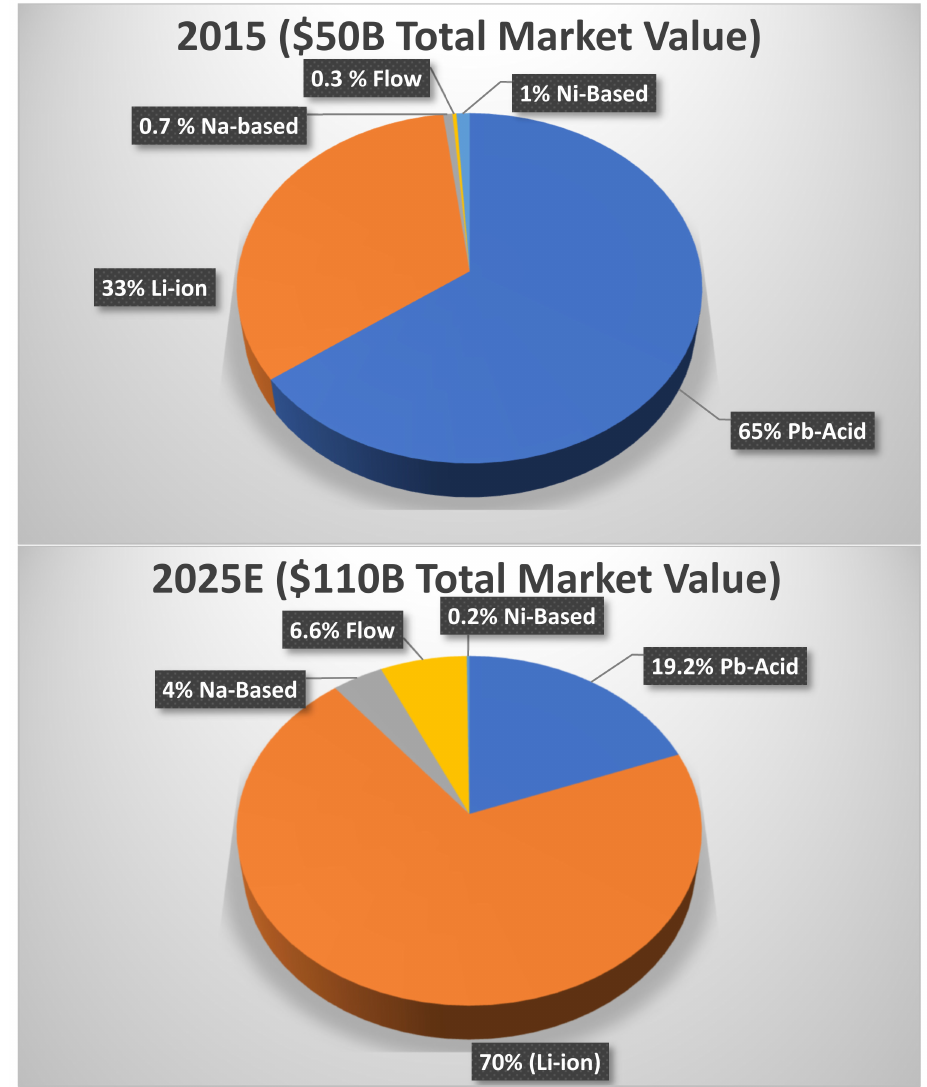
Figure 2. Rechargeable Li-ion battery market size (data derived from ref.